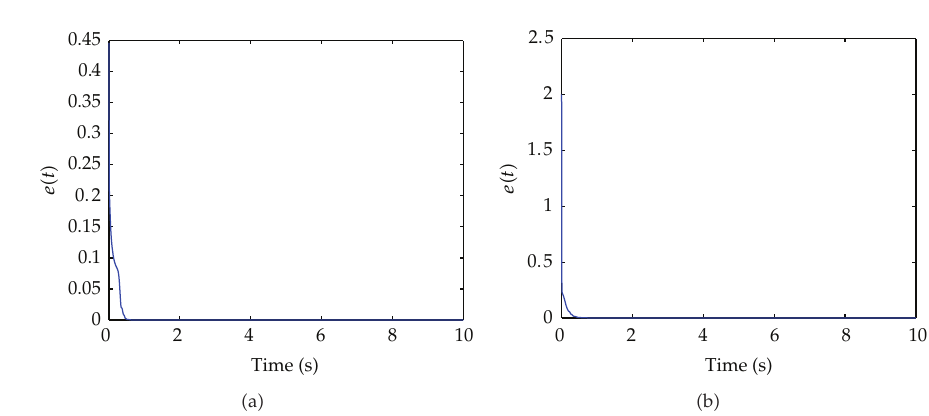
Figure 8: Error states of the drive system (cid:6) 3.1 (cid:7) and the response system (cid:6) control law (cid:6) 3.5 (cid:7) : (cid:6) a (cid:7) ; control law (cid:6) 3.15 (cid:7) : (cid:6) b (cid:7)(cid:7)